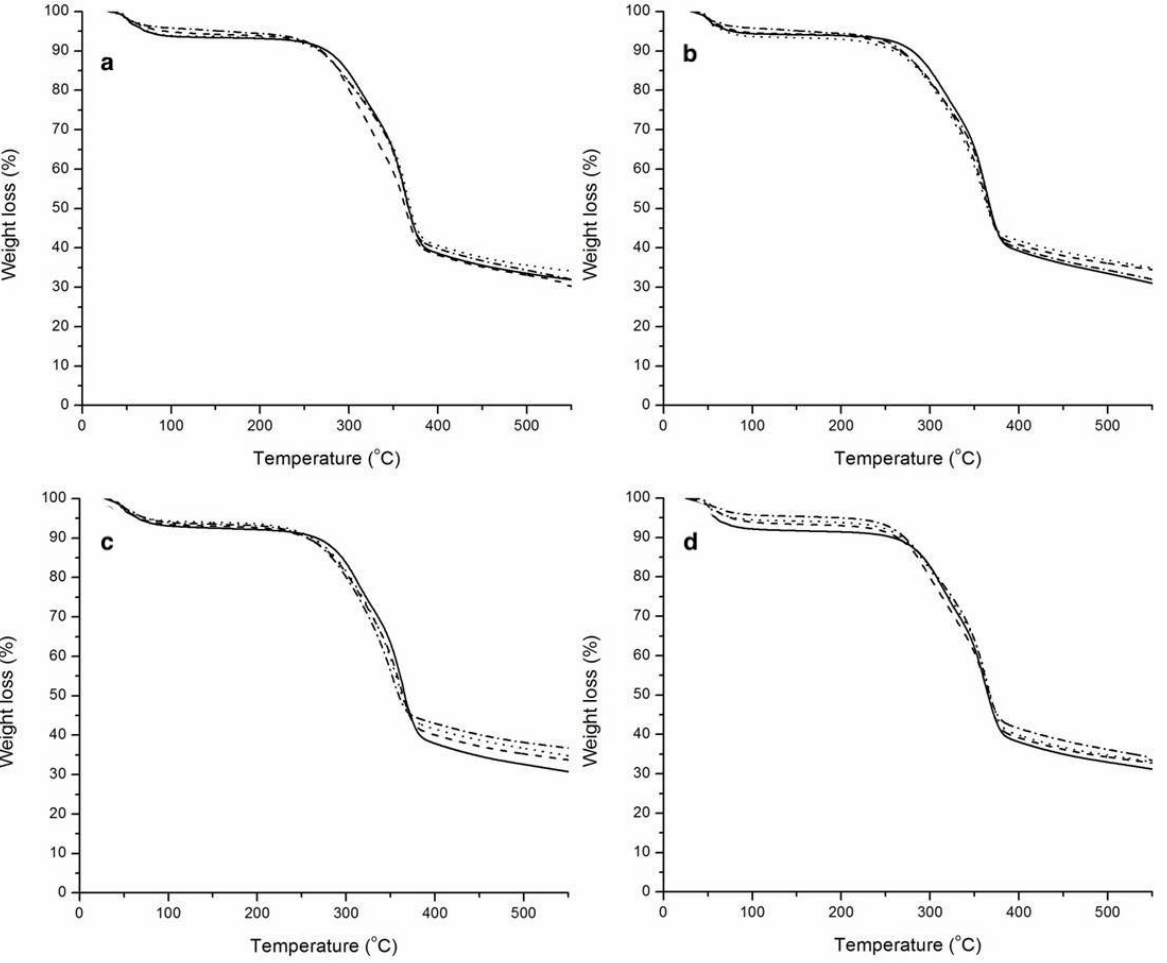
Figure 3. TGA thermograms of rice hull treated with [bmim][Ac] ( a and c ), and [bmim][Cl] ( b and d ), for 2 h ( a and b ), and 6 h ( c and d ). Legend: (—) untreated biomass, (----) IL 50 % and 75 °C, (. . . .) IL 100 % and 75 °C, and (-.-.-.) IL 100 % and 100